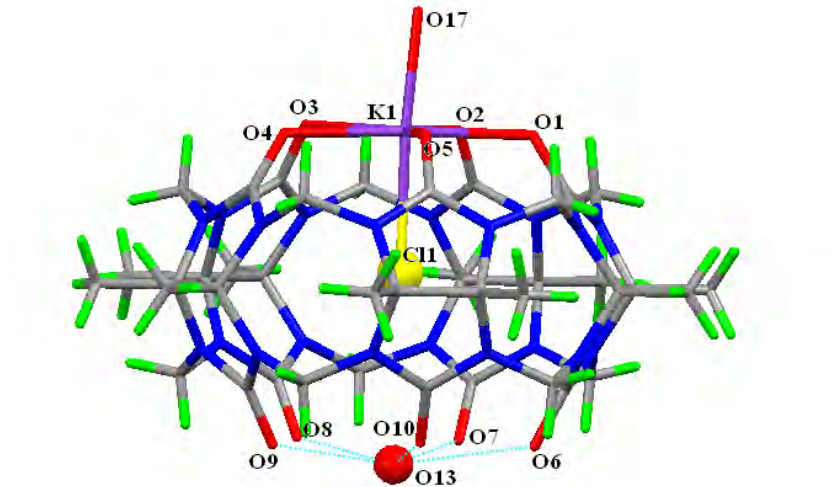
Figure 4. X-ray crystal structure of 3, anions and solvated water molecules and anions are omitted for clarity, except for